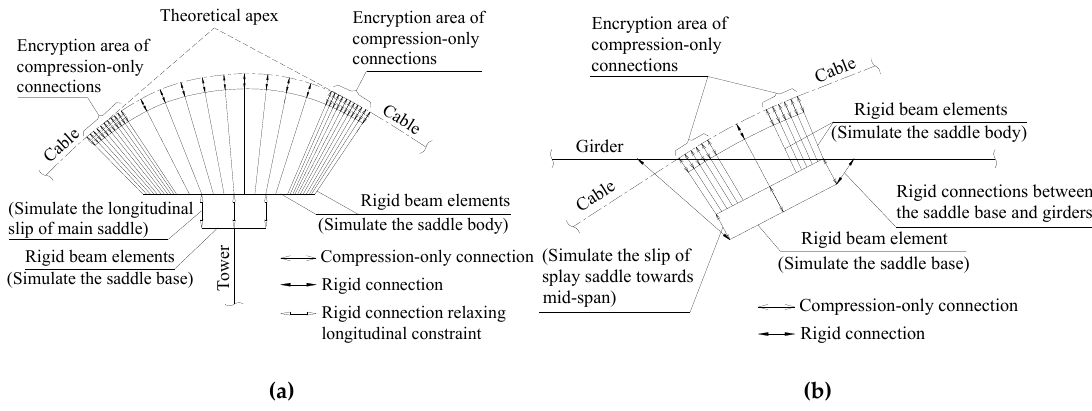
Figure 9. Refined FE models of cable saddles: ( a ) Main saddle. ( b ) Splay saddle.